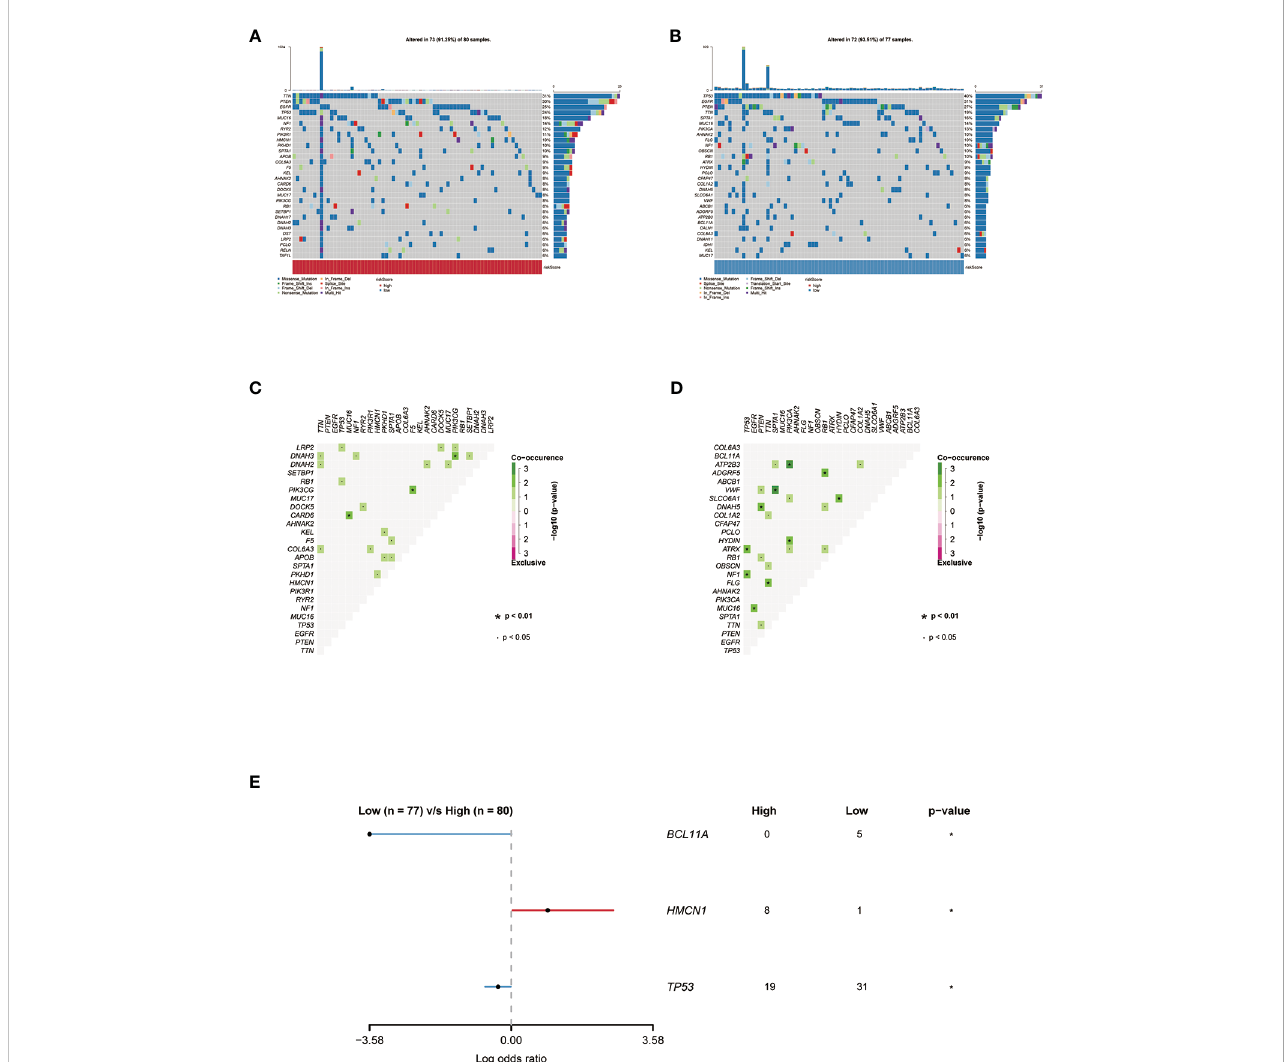
FIGURE 5 (A) Genes with the highest frequency of somatic mutations in the group with high risk scores are listed below. (B) Genes with the highest frequency of somatic mutations in the group with low risk scores are listed below. (C, D) The heatmap showing the concurrence or mutual exclusivity of the top 25 most mutated genes in the two clusters.p< 0.05, *p< 0.01. (E) The Forest plot listing the top 3 most mutated genes between the two clusters.